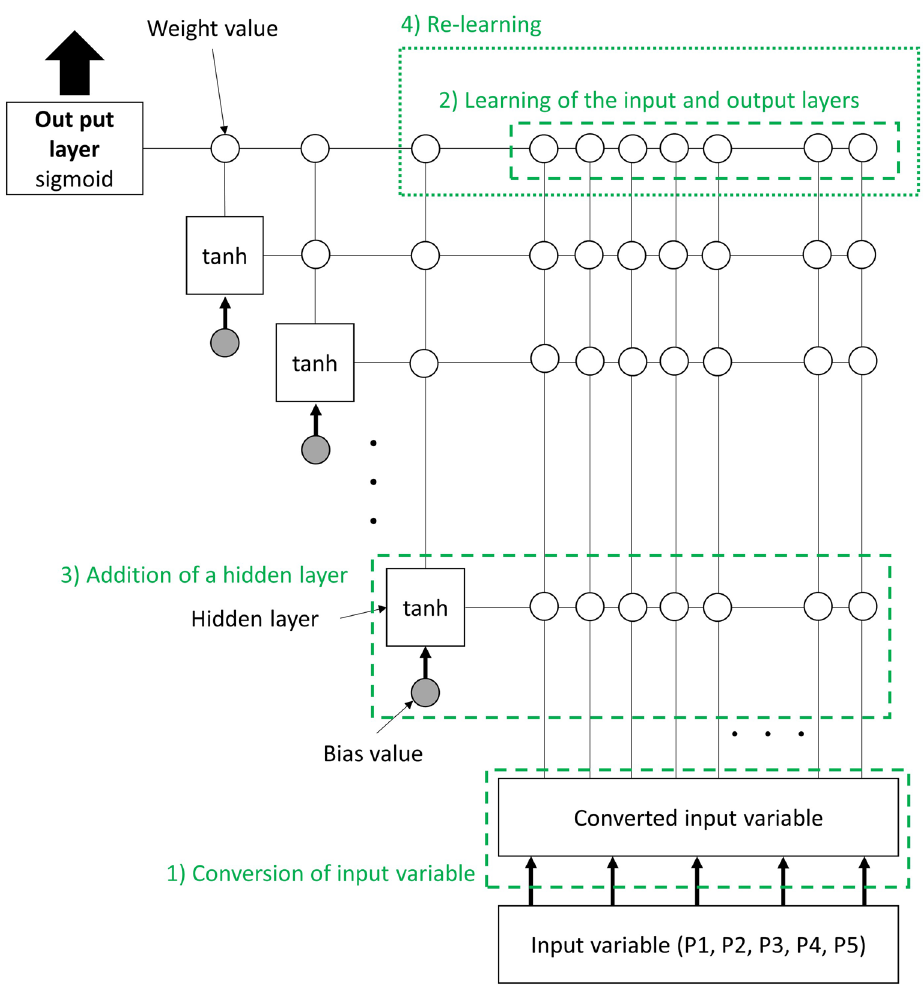
Figure 2. Flow of the network construction. The network was constructed by cascade correlation. The weight update method used was the adaptive subgradient method. The objective function was cross-entropy with added ridge